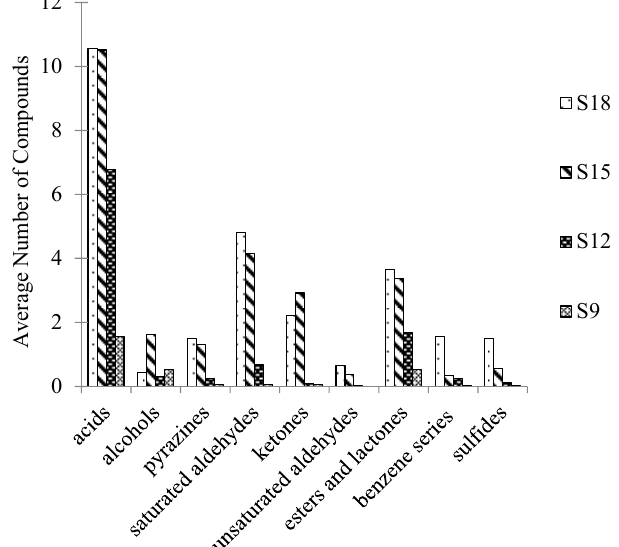
Figure 5. The category of compounds in Jinhua ham by DHS. D9, D12, D15 and D18 referred to Jinhua ham processed for 9, 12, 15 and 18 months and application of DHS for aroma extraction of sample,